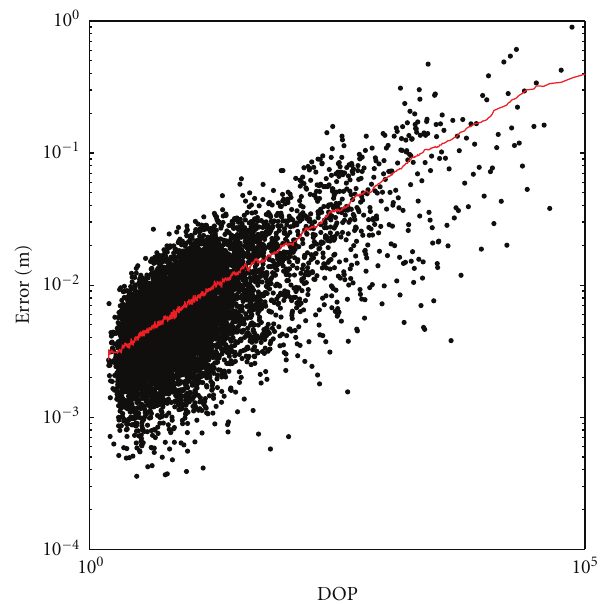
Figure 1: The error in the position estimation versus the dilution of precision for all antenna elements and 200 random probe configurations. The red line is a smoothed curve using a 500-point moving average.